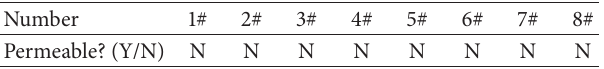
Table 3: Water proofing property of different modified asphalt waterproofing